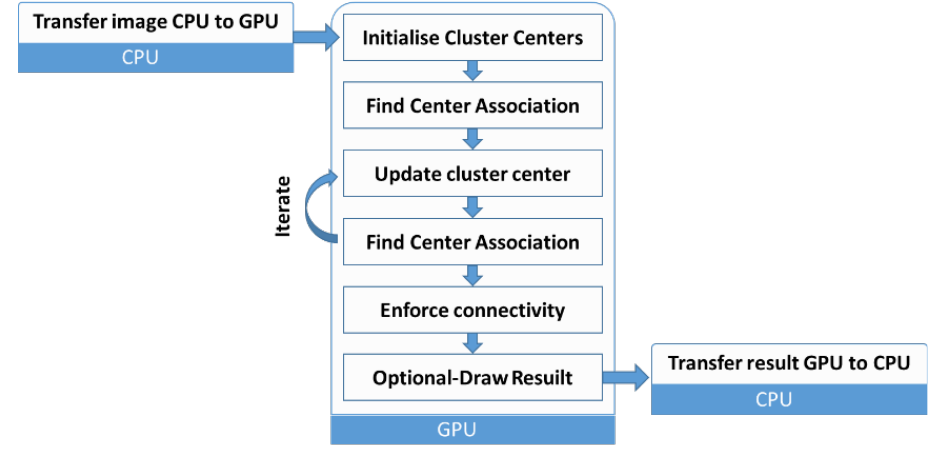
Figure 2. The workflow of gSLICr.